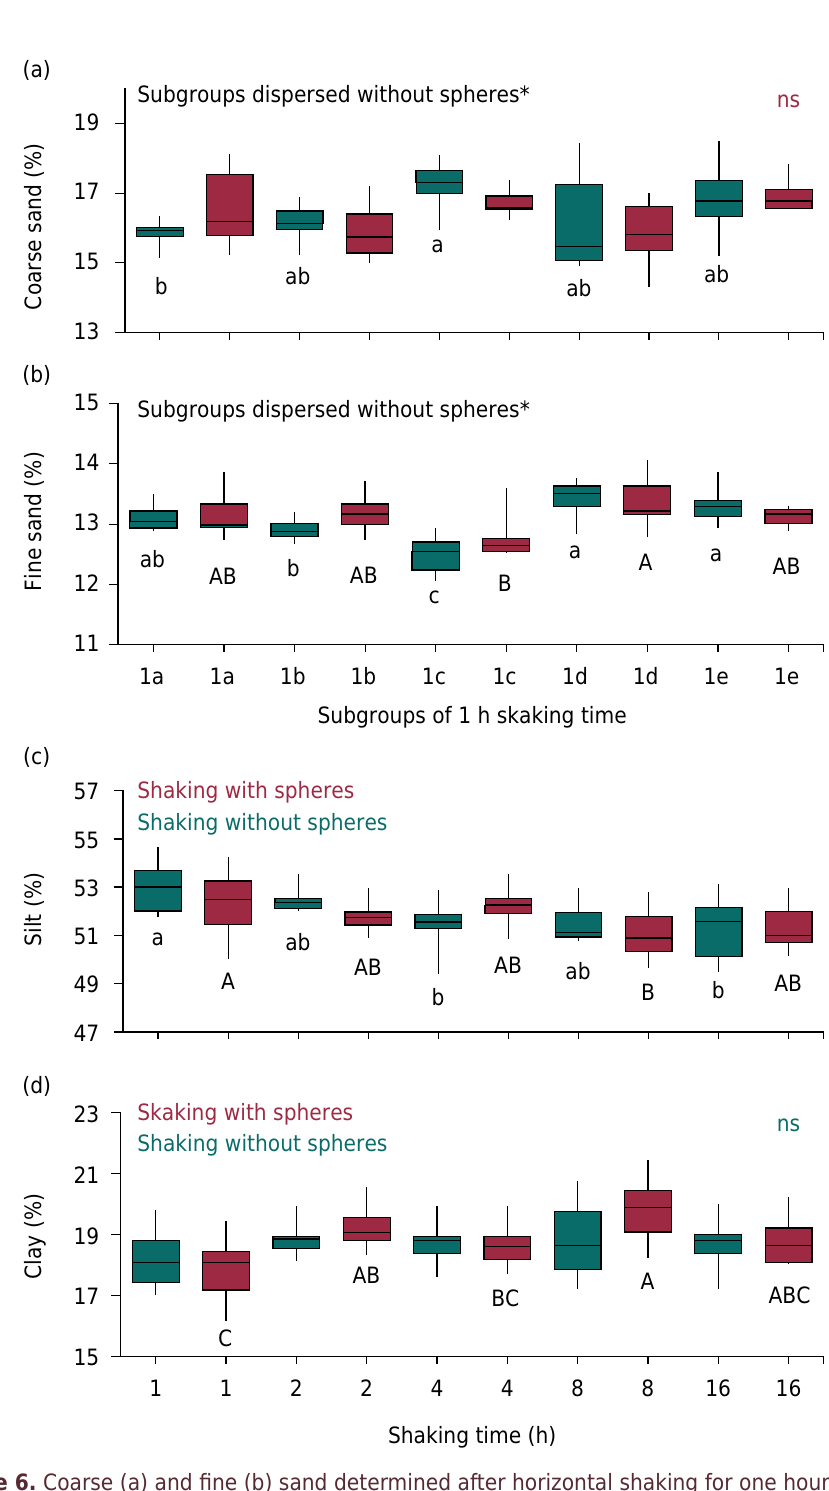
Figure 6. Coarse (a) and fine (b) sand determined after horizontal shaking for one hour without the use of spheres; silt (c) and clay (d) determined after horizontal shaking of up to 16 h with and without the use of spheres. * Sub-samples of coarse and fine sand dispersed without using spheres, corresponding to sub-samples of silt and clay shaken with spheres (red) and without spheres